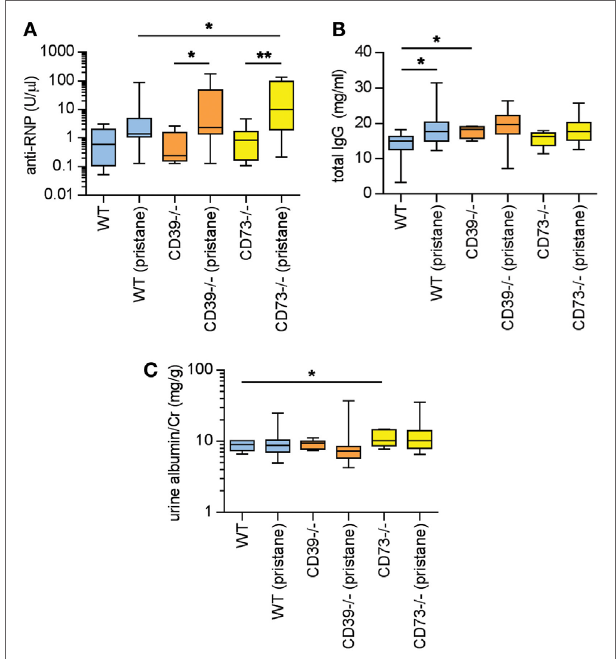
FigUre 2 | Ectonucleotidase deficiency potentiates autoimmunity in pristane-treated mice. Mice were administered either saline or pristane, as indicated. 36 weeks later, various endpoints were tested. (a) Anti- ribonucleoprotein (Anti-RNP) IgG was measured in serum. (B) Total IgG was measured in serum. (c) Spot albumin/Cr (albumin/creatinine) ratios in urine. N = 10 per control group and 17–19 per pristane group. * p < 0.05 and ** p <